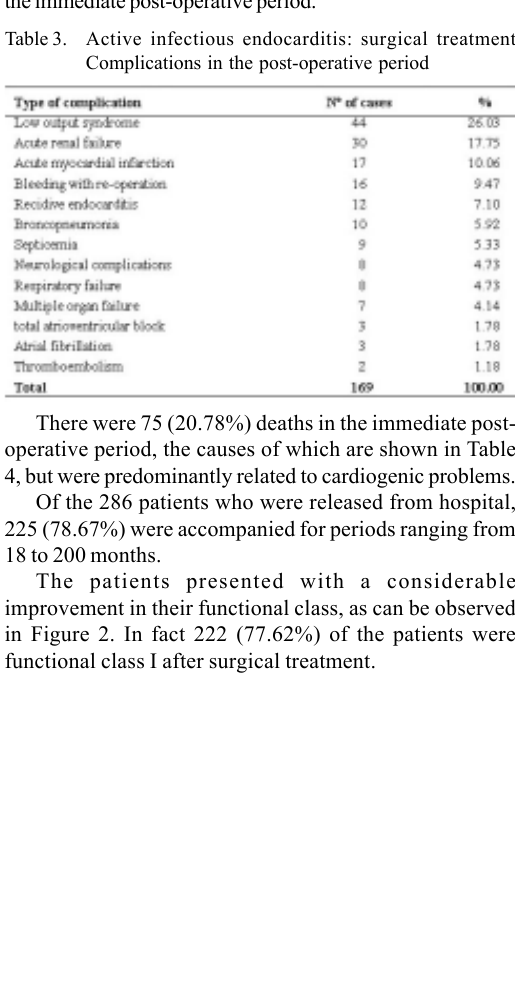
Fig. 1 - Active infectious endocarditis: surgical treatment Functional class - pre-operative period